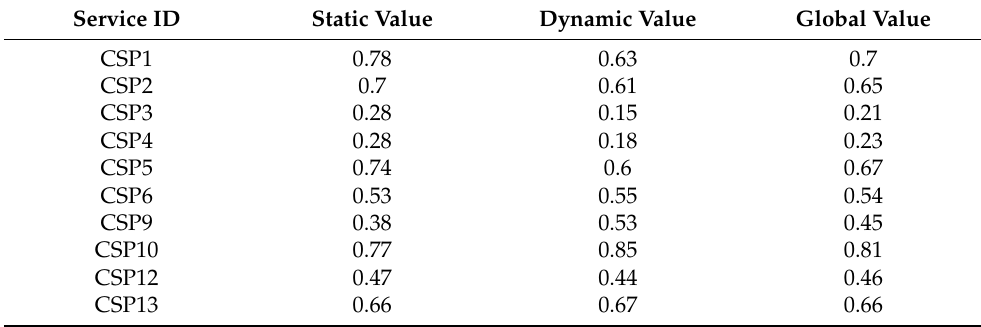
Table 5. The static value, dynamic value, and global value evaluation result of